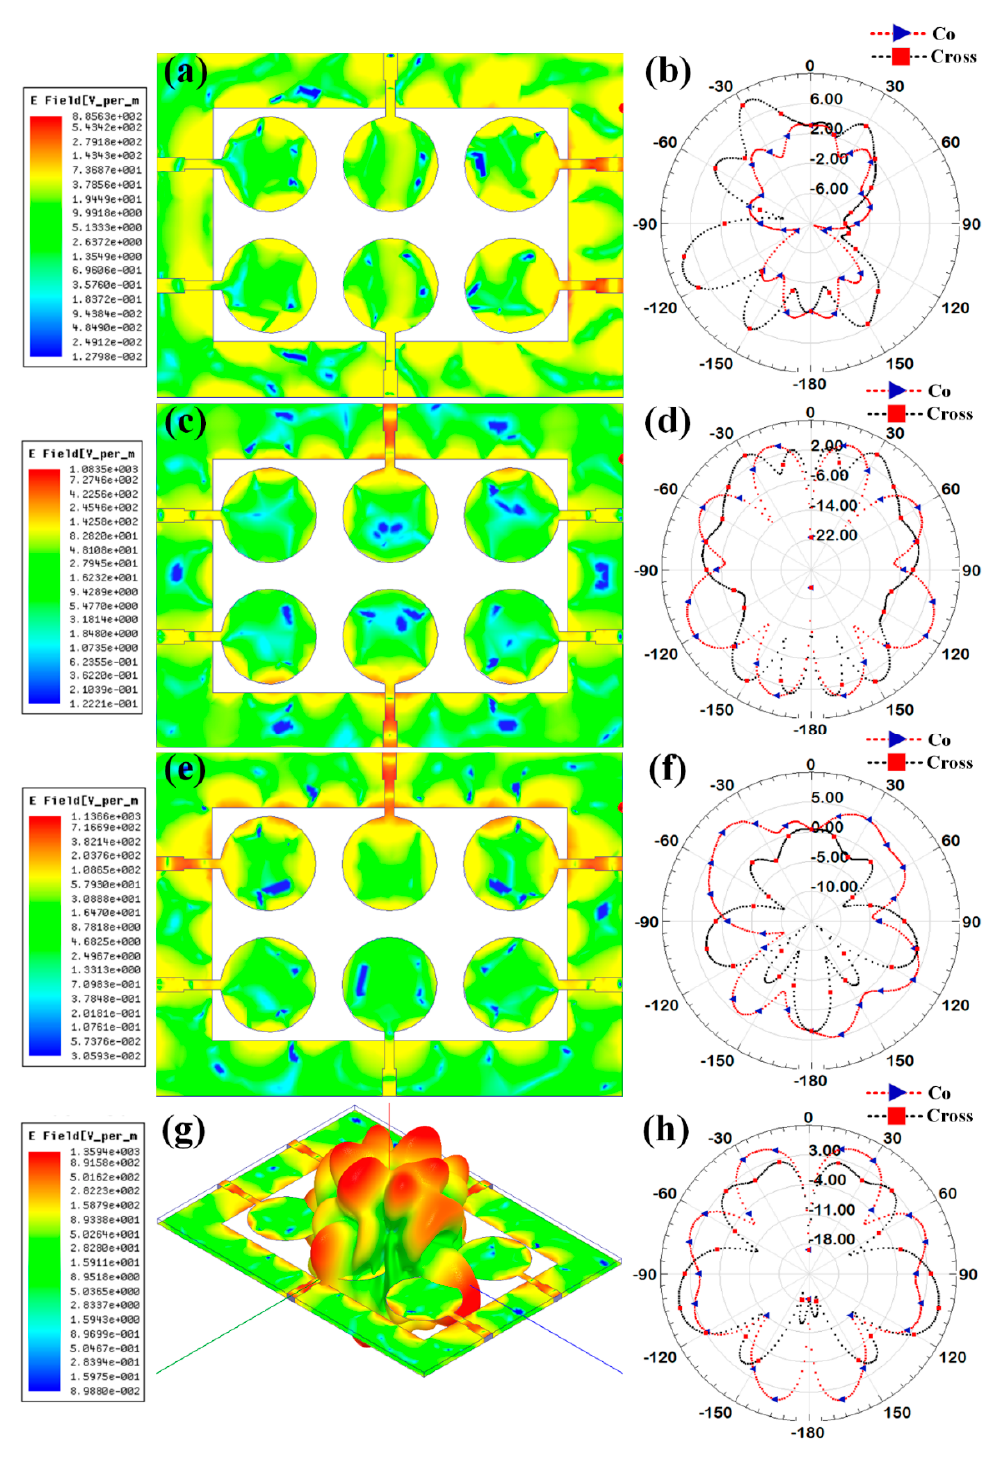
Figure 9. Electric field intensity and polar radiation pattern for the Design 3. Normalized electric field distribution for the different port excitation conditions such as ( a ) (P1 = 1, P2 = 1), ( c ) (P3 = 1, P6 = 1), and ( e ) (P1 = 1, P5 = 1, P6 = 1). Co-polarization and cross-polarization 2D radiation pattern for the different port excitation conditions such as ( b ) (P1 = 1, P2 = 1), ( d ) (P3 = 1, P6 = 1), and ( f ) (P1 = 1, P5 = 1, P6 = 1). ( g ) three-dimensional radiation pattern along with the electric field distribution for the all-port excitation conditions. ( h ) Co polarization and cross polarization 2D radiation pattern for all port excitation conditions.